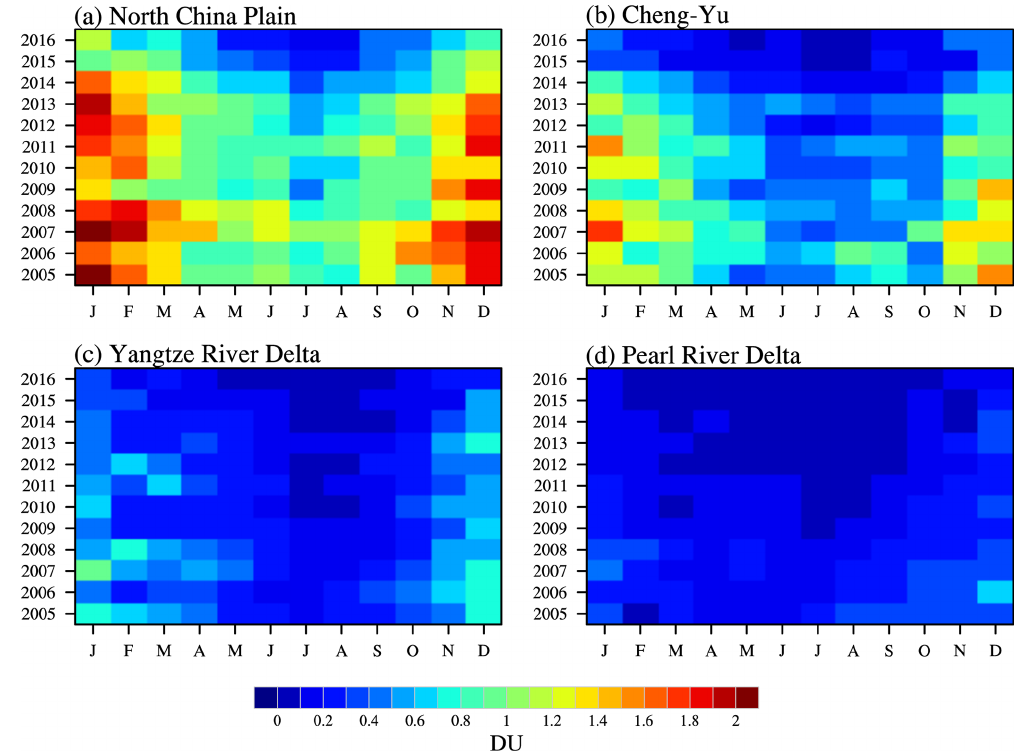
Figure 6. SO 2 amounts from 2005 to 2016 as a function of year ( y axis) and calendar month ( x axis) for NCP (a) , CY (b) , YRD (c) and PRD (d)